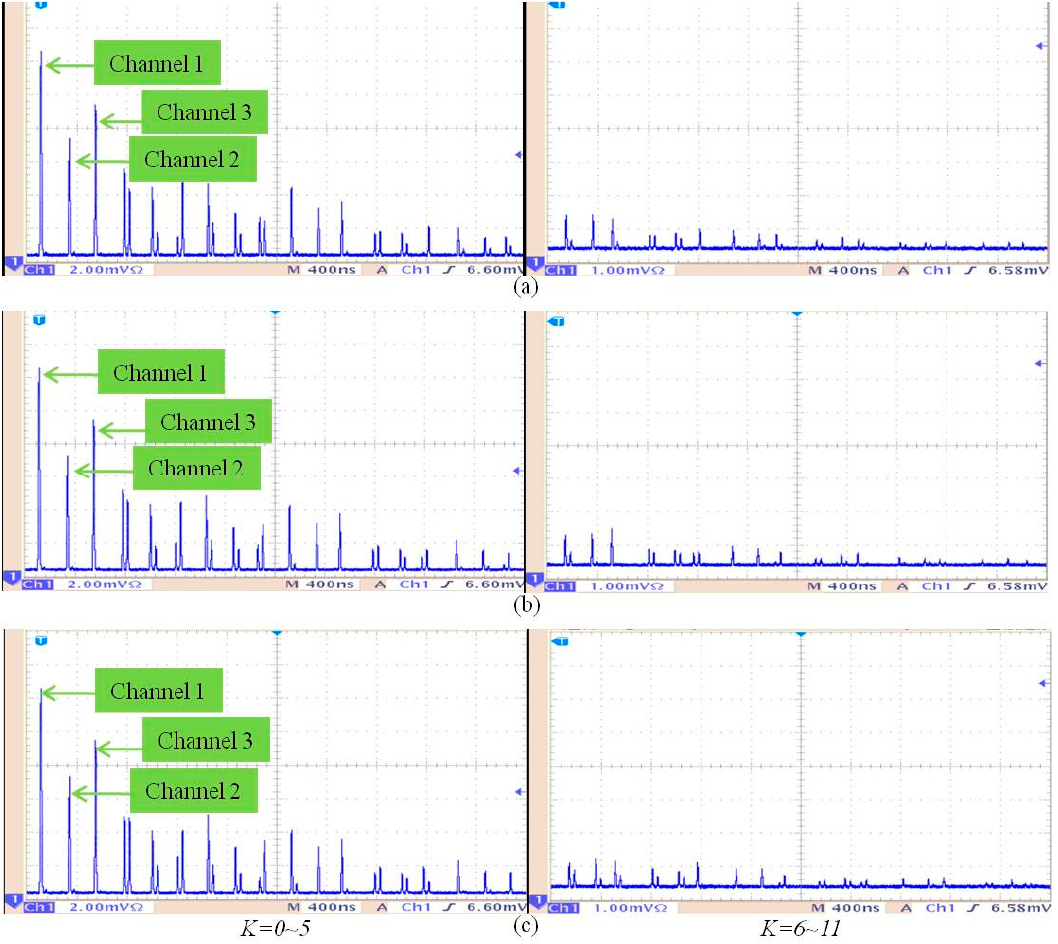
Figure 3. Intensity variations of light pulses taken from a Tektronix TDS3054B 500 digital oscilloscope (Tektronix, Beaverton, WA, USA): ( a ) three channels for currents of 0 A, respectively; ( b ) three channels for currents of 500 A, 500 A, and 1000 A, respectively; ( c ) three channels for currents of 1000 A, 1000 A, and 2000 A, respectively.